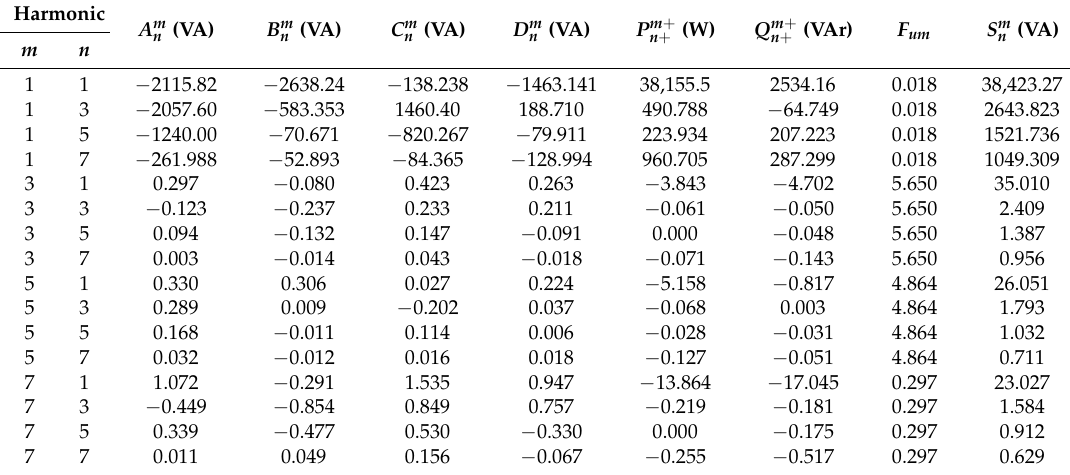
Table 5. Results in Bus 1.